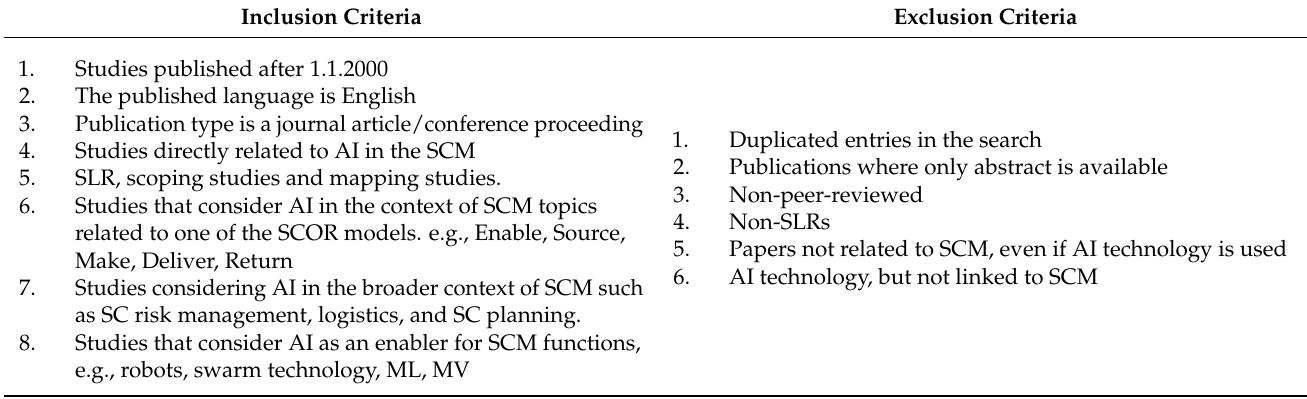
Table 5. Inclusion and exclusion criteria for SLRs.